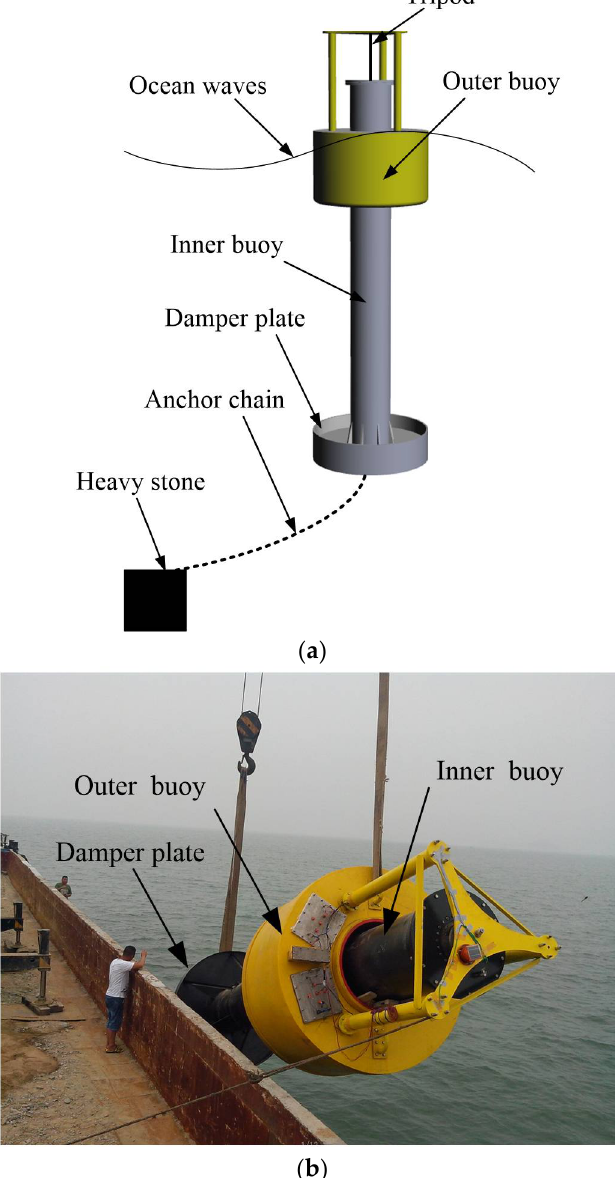
Figure 4. The two-buoy offshore ocean wave power generation system. ( a ) General scheme; ( b ) Installation process.